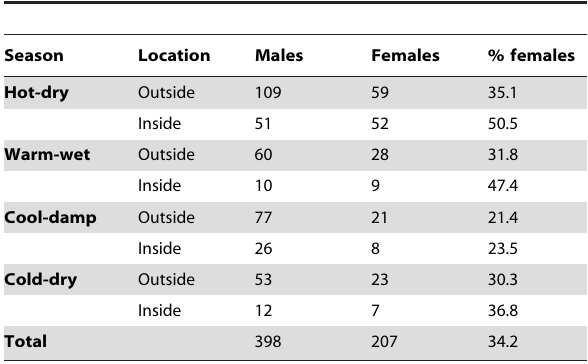
Table 1. Catch of G. m. morsitans caught from men inside or outside at various seasons.